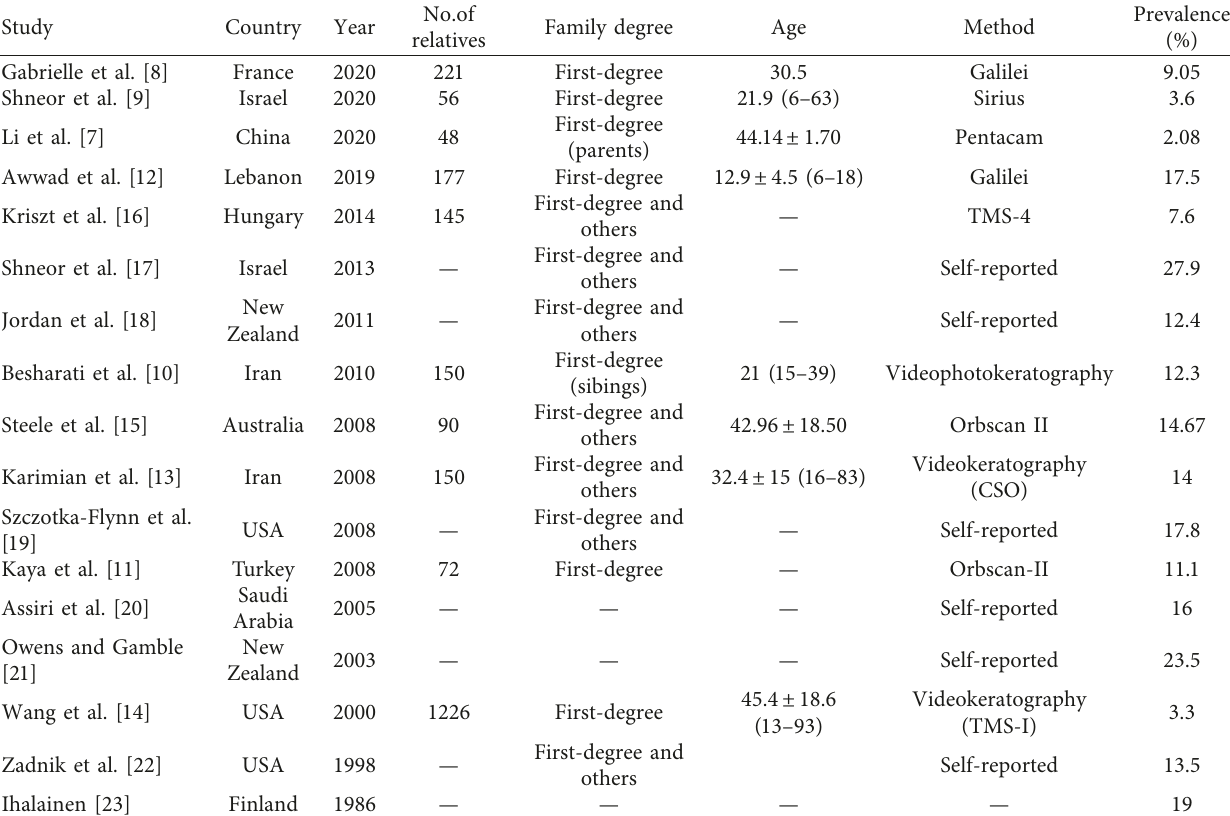
Table 4: Previous studies of the prevalence of keratoconus among first-degree relatives.